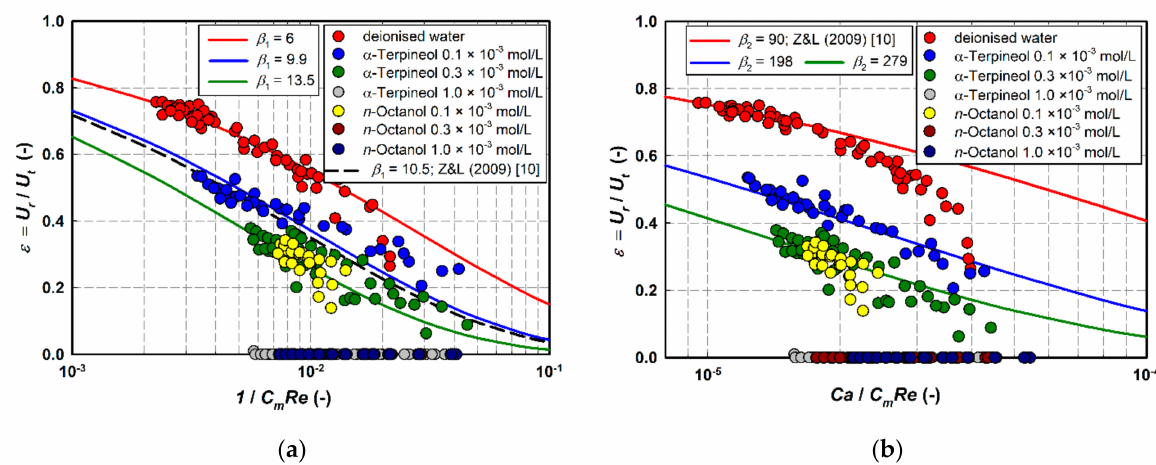
Figure 5. The restitution coefficient for the used liquids; ( a ) expression of Equation (1), where the restitution coefficient is the exponential function of the inverse value of the square root of the modified Reynolds number; ( b ) expression of Equation (2), where the restitution coefficient is the exponential function of the square root ratio of the capillary number and the modified Reynolds